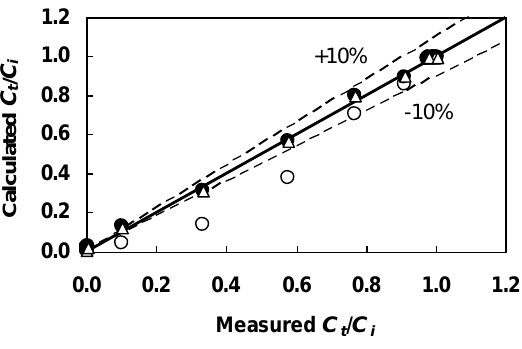
Figure 9. Comparison between the Figure 7 breakthrough data and C the Bohart-Adams equation (Equation (11)) with the linear regression-derived parameters (open circles) and GA-generated parameters (filled circles) tabulated in Table 6. Also shown are C / C calculated from the Belter-Cussler-Hu equation (Equation (13)) with the t i GA-derived parameters (triangles) given in Table